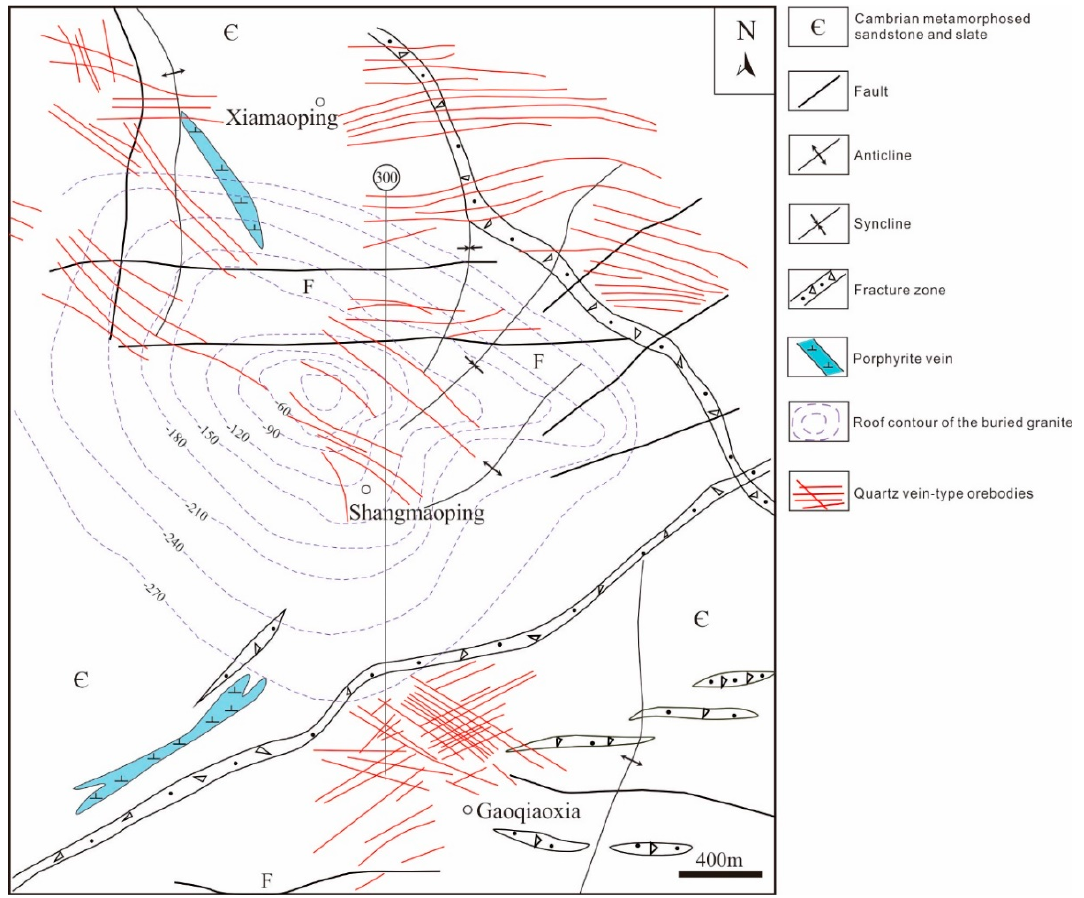
Figure 2. A schematic geological map of the Maoping tungsten deposit (modified from [48]).